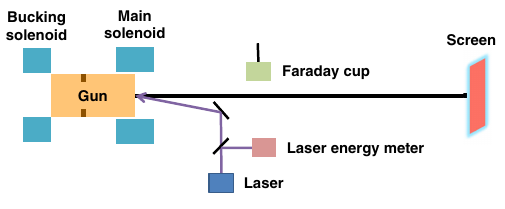
FIG. 1. Schematic of the experimental